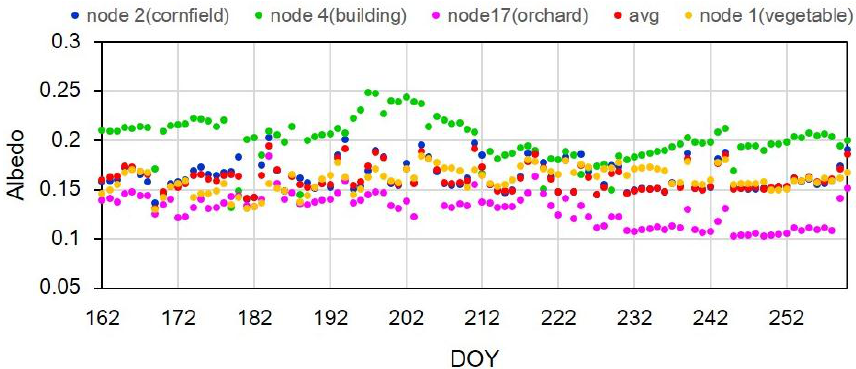
Figure 6. Time series of surface albedo over cornfield (taking Node 2 for example), building, orchard, vegetable and the field mean value over the study